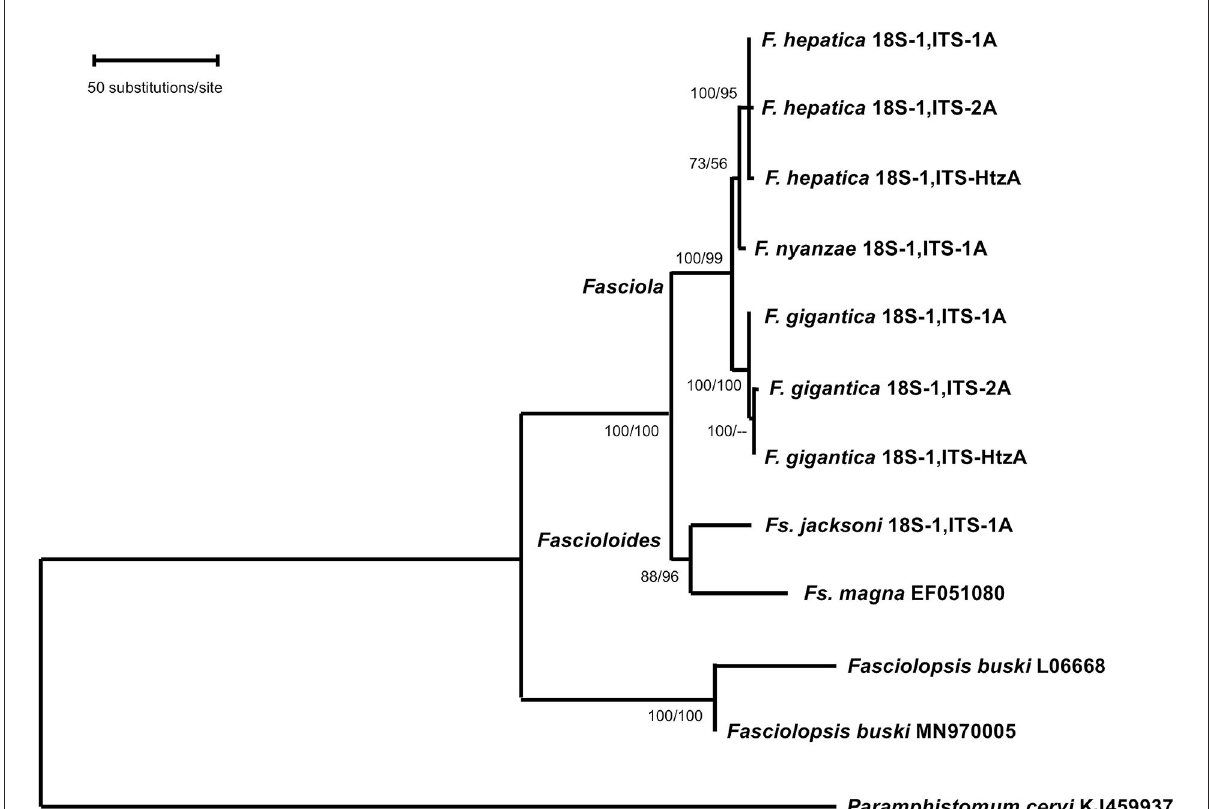
FIGURE3 Phylogenetic tree of species of Fasciola , Fascioloides, and Fasciolopsis based on maximum-likelihood (ML) estimates and reconstructed on the concatenated sequences of the nuclear rDNA 18S gene, ITS-1, 5.8S gene and ITS-2 (lnL = − 7,832.871). The tree is drawn to scale, with branch lengths measured in the number of substitutions per site. The tree was rooted using the sequence of Paramphistomum cervi (KJ459937) as outgroup. Supports for nodes a/b using MEGA X: a, bootstrap (1,000 replicates) with ML parameters (HKY + G); b, bootstrap (1,000 replicates) with NJ and number of differences method for